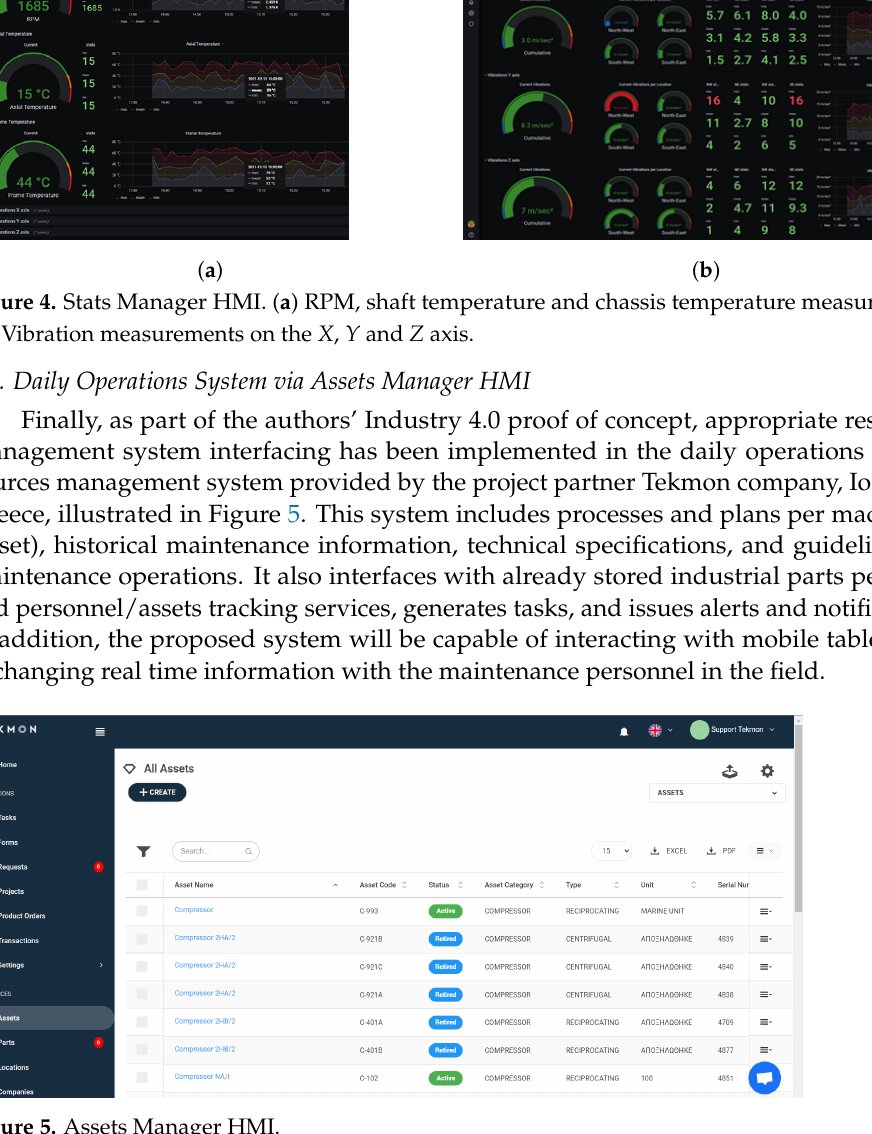
Figure 5. Assets Manager